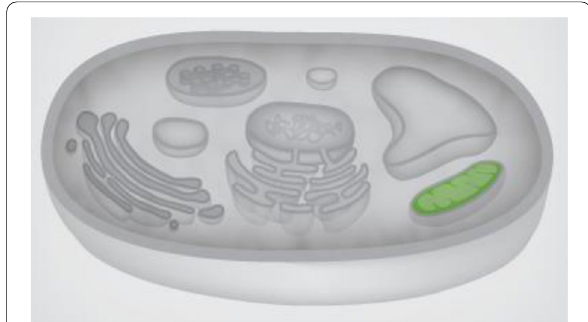
Fig. 6 Subcellular localization of AmCoc mitochondrial protein predicted by PredictProtein